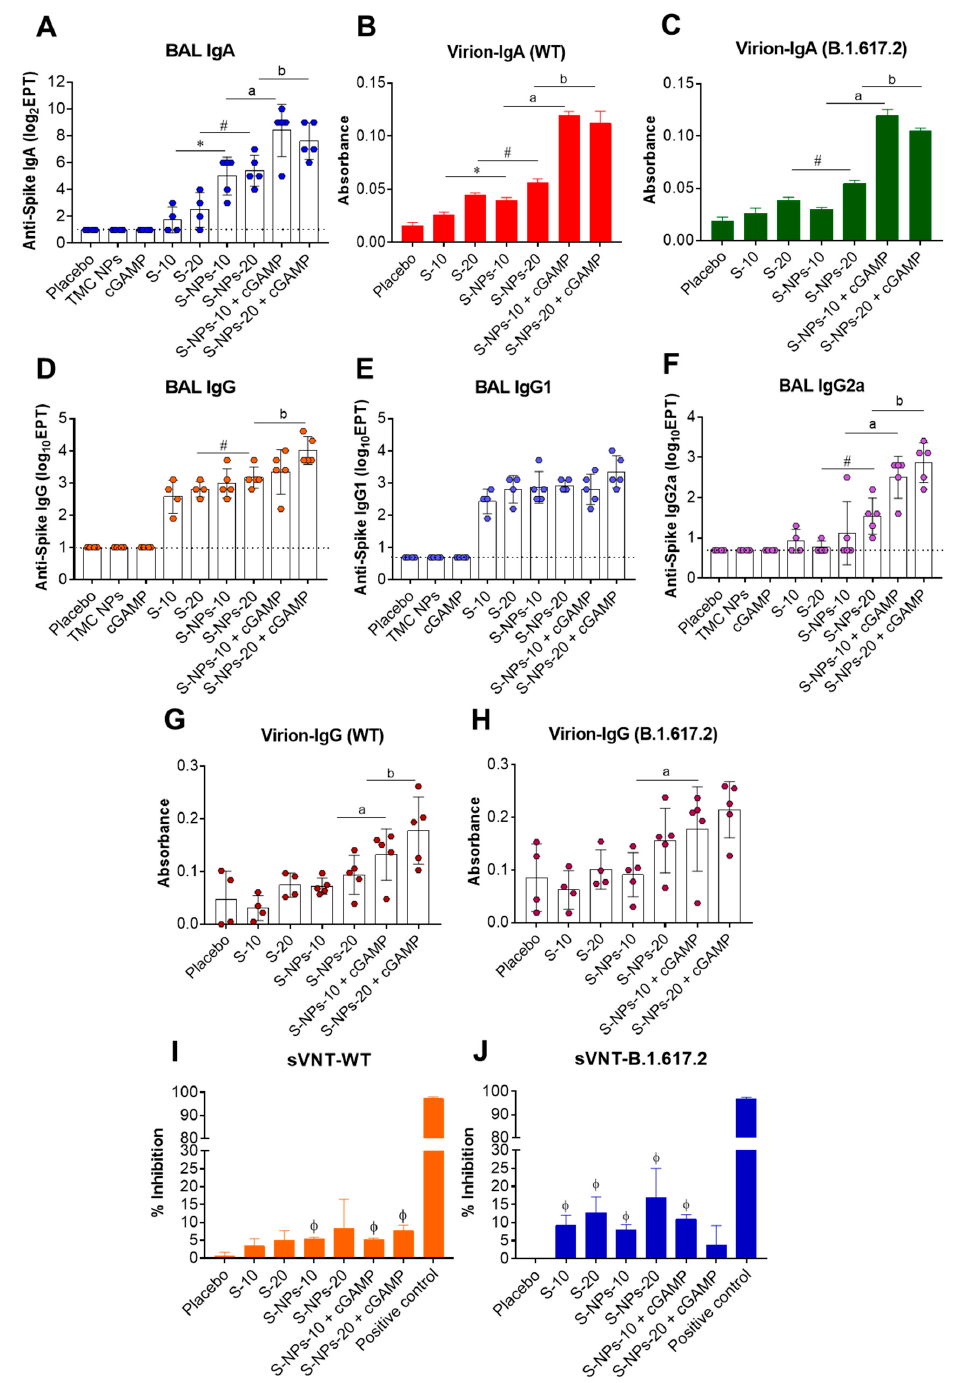
Figure 2. Mucosal immune responses in BALs of immunized mice. BALs were collected from immunized mice on day 45. S-IgA titers were determined by indirect ELISA ( A ). The levels of WT virion-IgA ( B ) and Delta variant (B.1.617.2) virion-IgA ( C ) in pooled BALs at 1:2 dilution were measured using virion-IgA capture ELISA with three independent experiments. Levels of spike-specific IgG ( D ), IgG1 ( E ), and IgG2a ( F ) antibodies were quantitated by ELISA. BALs at a dilution of 1:10 were analyzed for WT virion-IgG ( G ) and Delta variant virion-IgG ( H ) capture ELISA assays. The potential neutralizing activity against WT ( I ) and Delta variant ( J ) in BALs at a final dilution of 1:2 was monitored by surrogate virus neutralization assay (sVNT). Results are shown as mean ± SD. “a” and “b” indicate significant differences between S-NPs and S-NPs + cGAMP at 10 and 20 µ g/dose, respectively ( p < 0.05). Dotted line indicates LoD of the